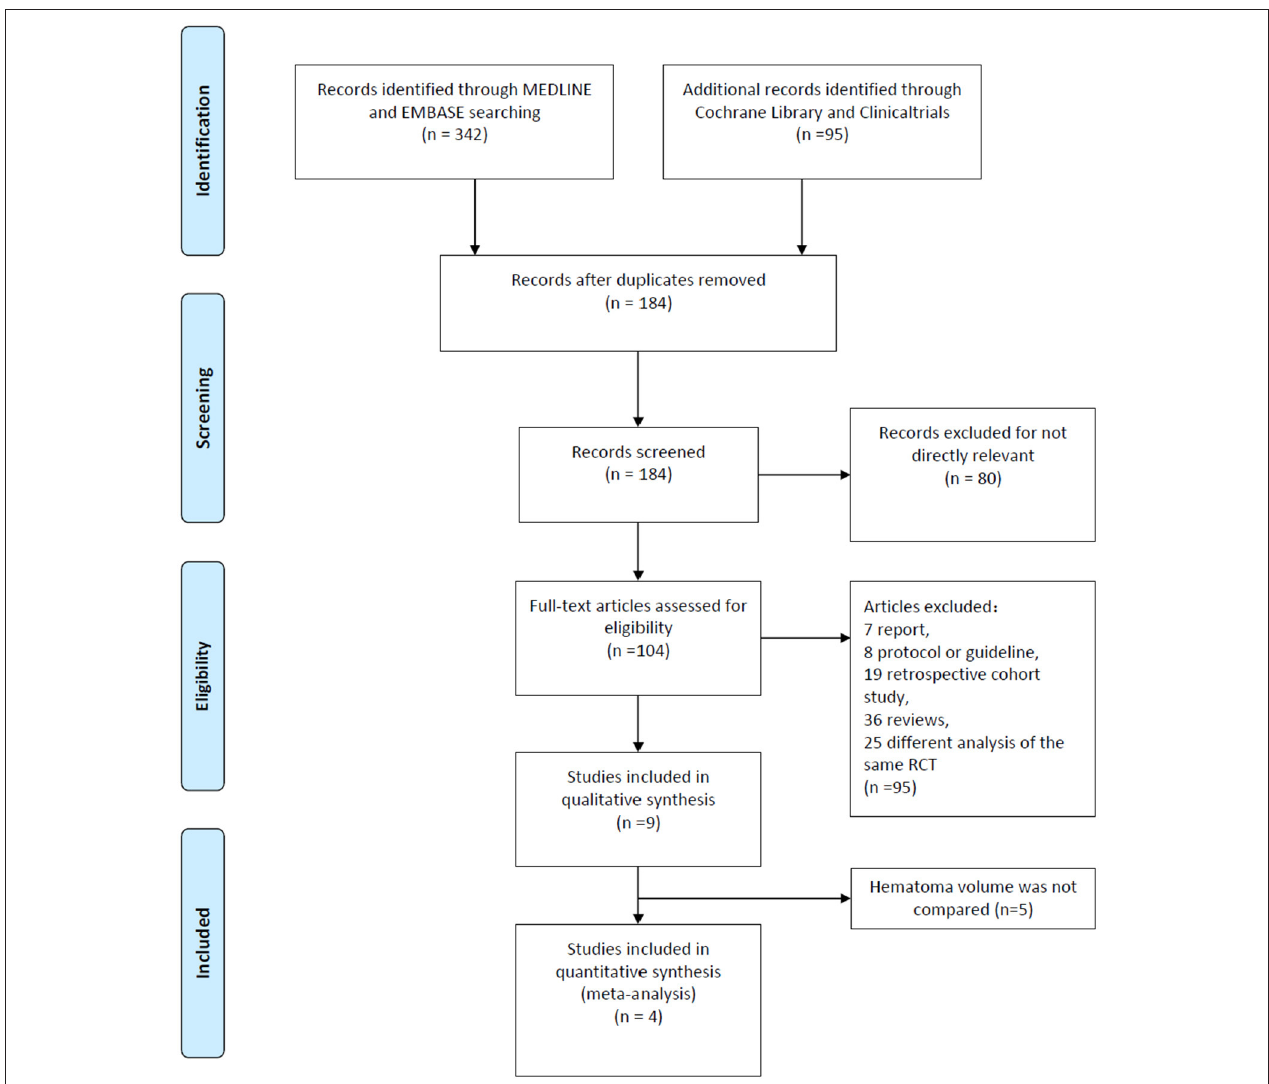
FIGURE 1 | The study search, selection and inclusion